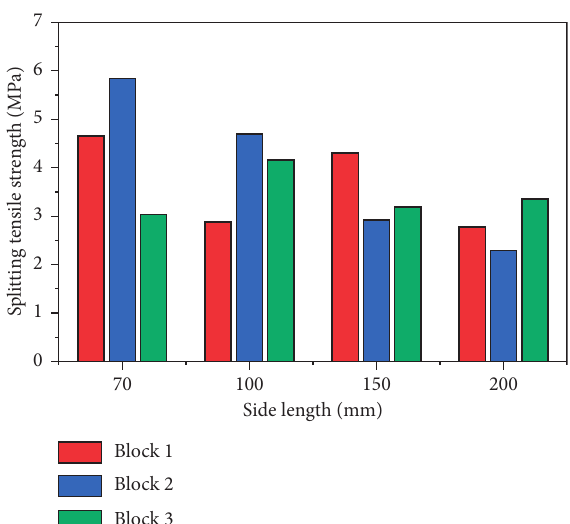
Figure 6: Splitting tensile strength values of cube specimens.